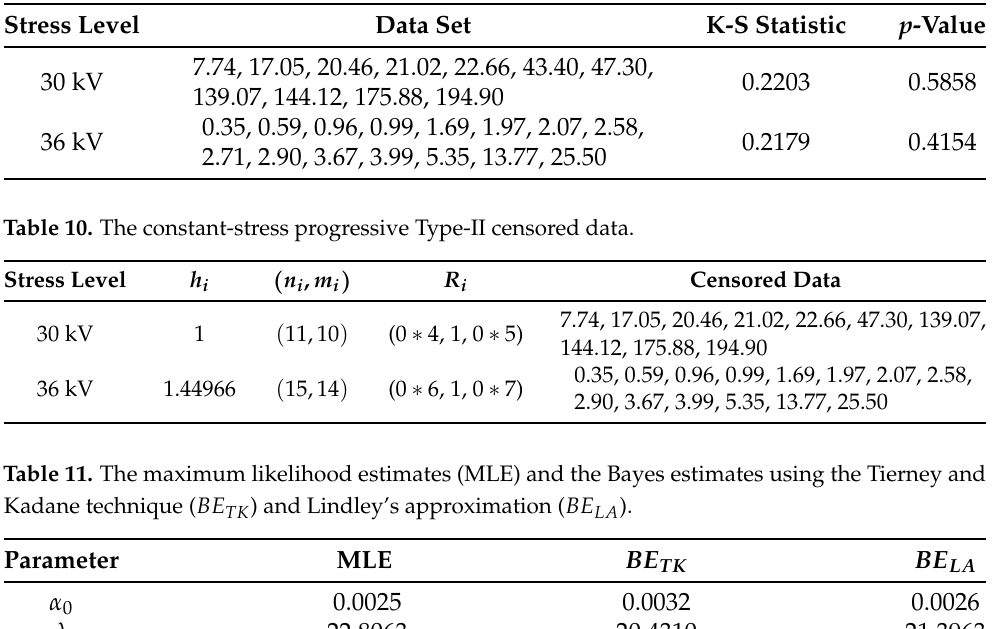
Table 9. The complete failure data and the fitting results.